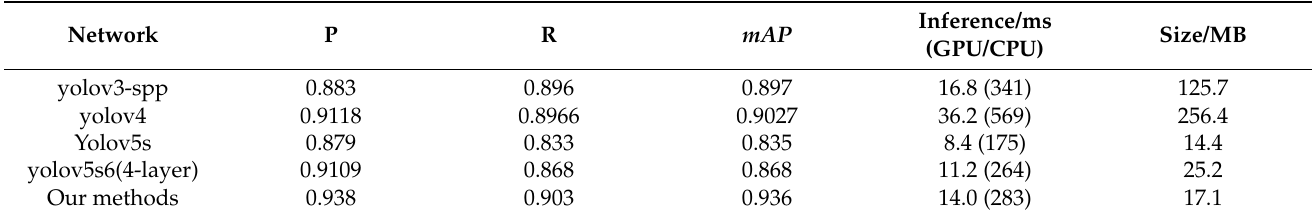
Table 3. Performance of peer defect target detection algorithms on the RR dataset (the one-stage).